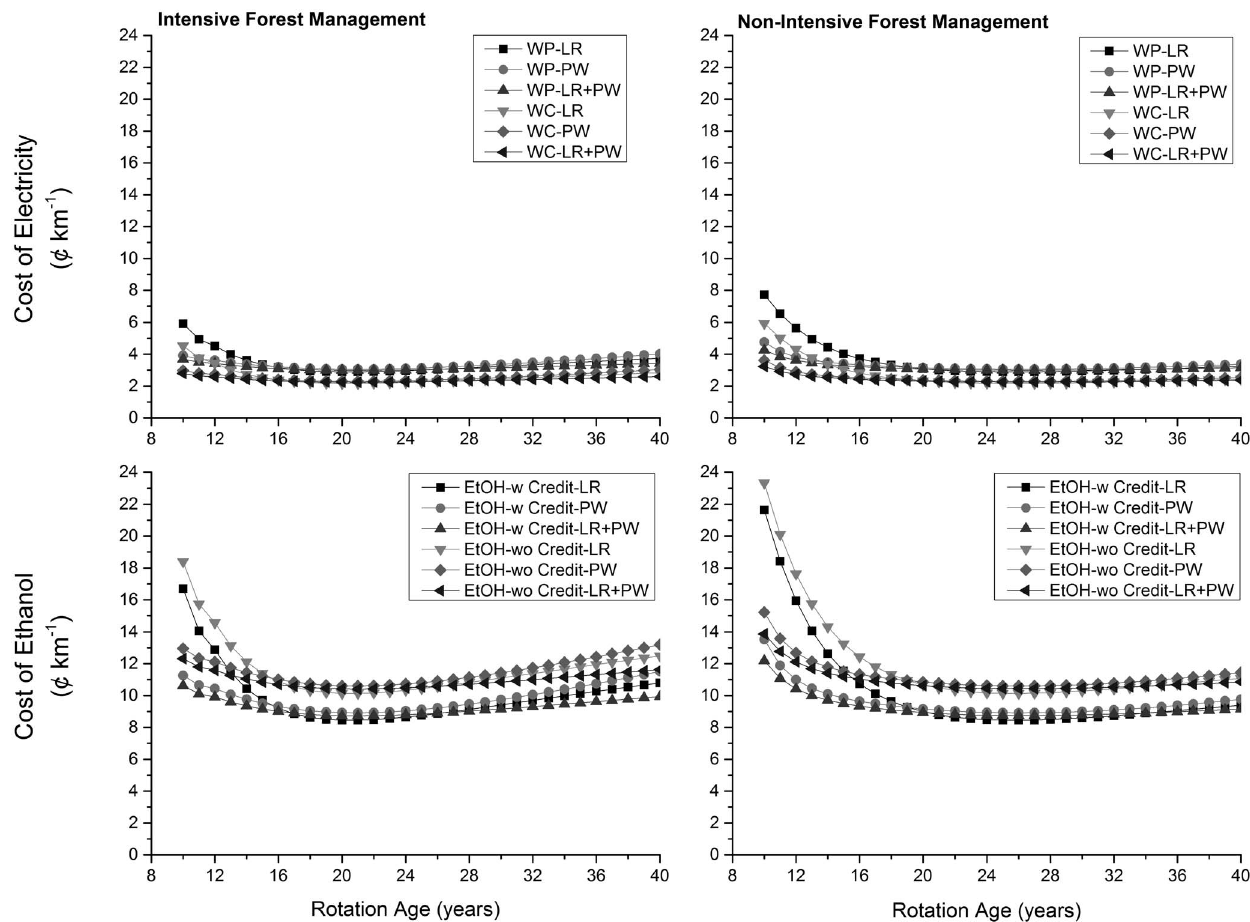
Figure 5. Cost of energy products at the consumption level. LR: logging residues; PW: pulpwood; WP: wood pellets; WC: wood chips; w: with income from cogenerated electricity; wo: without income from cogenerated electricity.